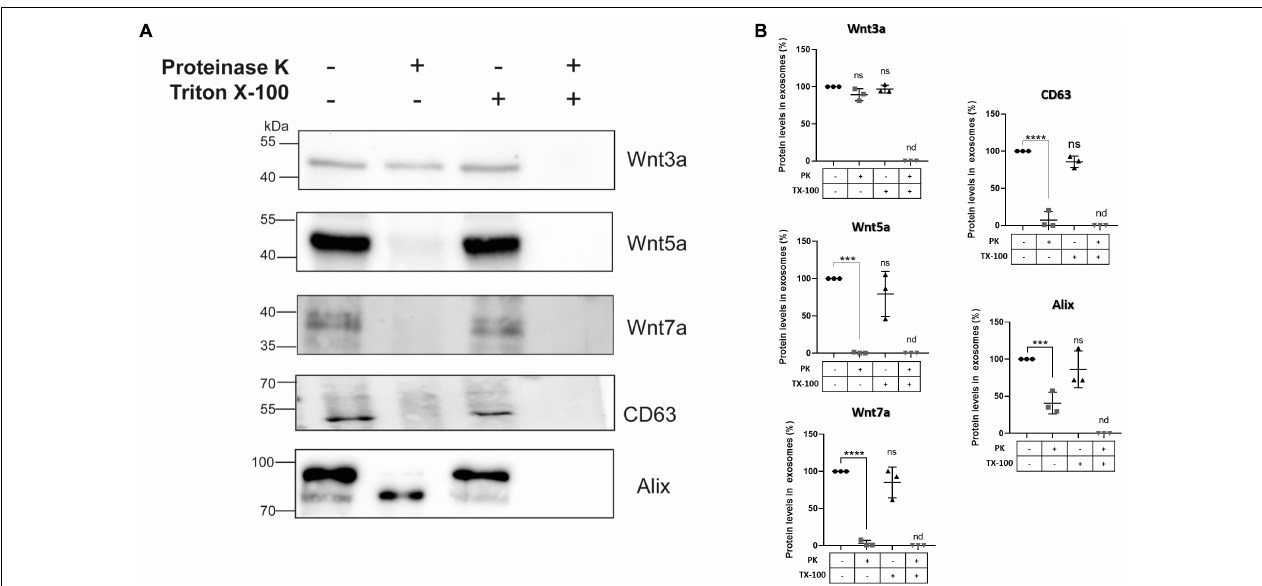
FIGURE 6 | Effects of proteinase K treatment on sEVs Wnt ligand contents. HT-22 cells-derived sEVs were treated with proteinase K in the absence and presence of Triton X-100 (see section “Materials and Methods”). (A) Proteinase K treatment did not affect the Wnt3a ligand presence. However, plasma membrane permeabilization with 0.5% Triton X-100 and co-treatment with proteinase K resulted in its disappearance. On the other hand, proteinase K treatment alone resulted in marked declines or even disappearance of Wnt5a, Wnt7a ligands, and the exosomal marker CD63. However, in the case of Alix, a band shift was produced (see comments in the section “Discussion”). Triton X-100 and co-treatment with proteinase K also resulted in the disappearance of CD63 and Alix. (B) The graphs show the relative protein expression levels with the different treatments. The staining intensity of each band derived from control P100 was assigned a value of 100%, and the value obtained in the P100 from the different treatments was compared with its respective control (100%). Wnt3a: 89.33 ± 8.02 (PK; p = 0.0638); 96.87 ± 5.32 (TX-100; p = 0.7695). Wnt5a: 0.41 ± 0.20 (PK; p = 0.002); 79.34 ± 30.33 (TX-100; p = 0.2904). Wnt7a: 3.02 ± 2.02 (PK; p < 0.0001); 85.14 ± 20.65 (TX-100; p = 0.2673). CD63: 7.23 ± 7.0 (PK; p < 0.0001); 85.73 ± 7.63 (TX-100; p = 0.0842). Alix: 40.72 ± 14.59 (PK; p < 0.0025); 86.23 ± 24.73 (TX-100; p = 0.5365). n.d., not detected; PK, proteinase K; TX-100, triton X-100. Mann–Whitney non-parametric t -student test (ns, not significant; *** p < 0.005; **** p < 0.0001).